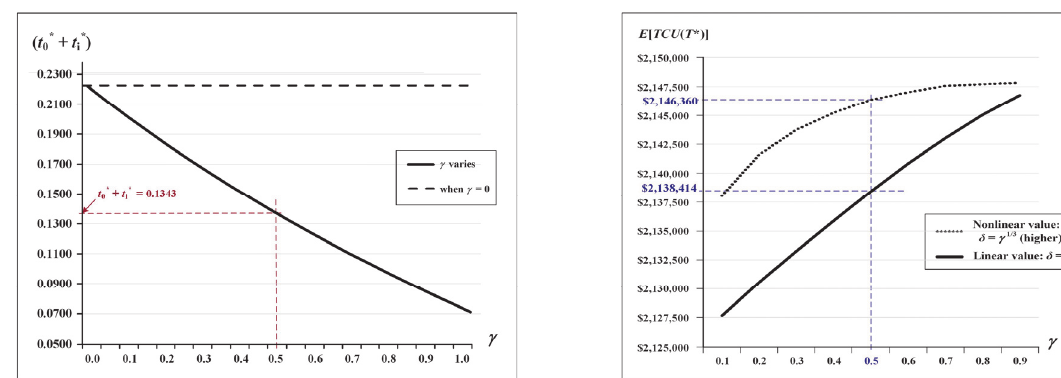
Fig. 13. Impact of changes in common part’s completion rate γ on ( t 0 * + t i * )